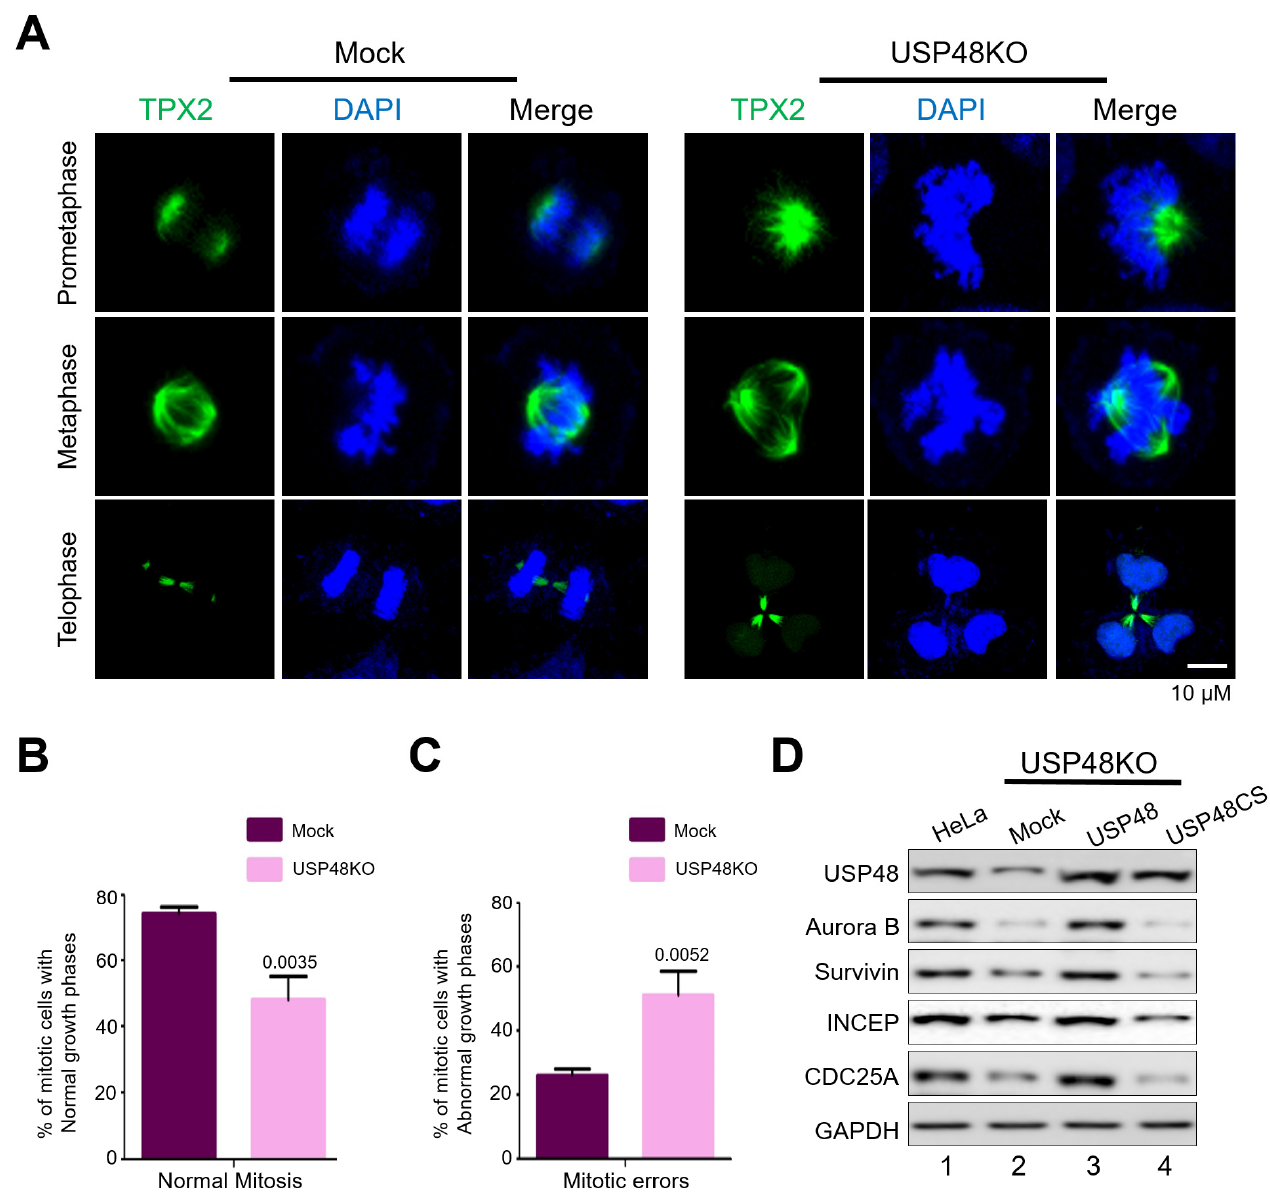
Figure 5. USP48 regulates Aurora B function during mitosis. ( A ) The spindle assembly factors in mock (left panel) and USP48KO (right panel) HeLa cells were stained with TPX2 antibodies. DAPI was used to stain the nuclei. Scale bar = 10 µM. Mitotic defects were observed upon depletion of USP48. The graph represents the percentage of cells exhibiting ( B ) normal mitotic phases in mock (74 ± 2), and USP48KO (48 ± 7) and ( C ) abnormal mitotic phases in mock (26 ± 2) and USP48KO (51 ± 7.55) ( n = 3, p values are represented on each graph). ( D ) USP48KO HeLa cells (lane 2) were transfected with either Flag-USP48 (lane 3) or Flag-USP48CS (lane 4) and compared with wild-type HeLa cells (lane 1). Transfected cells were synchronized with 100 ng/mL Nocodazole for 18 h prior and analyzed by Western blot against the indicated antibodies.